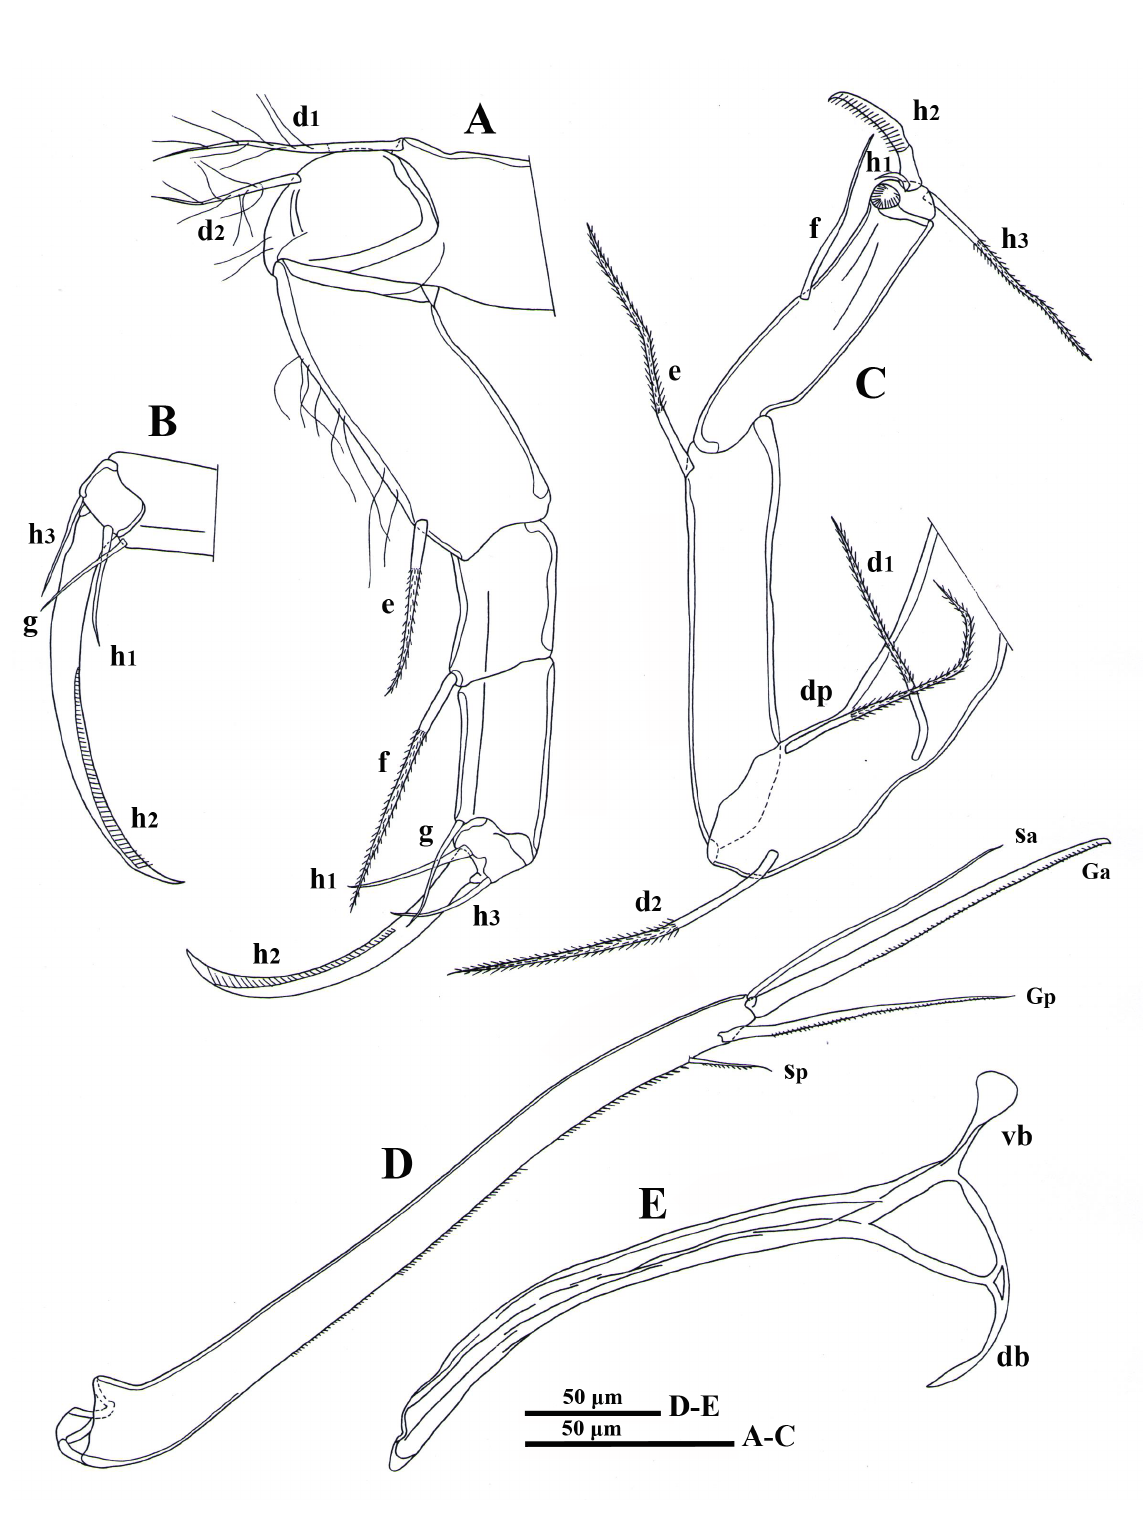
Fig. 5. Pseudostrandesia ratchaburiensis sp. nov. Paratype, ♀ (MSU-ZOC. 292). A . T2. B . Distal part of T2. C . T3. D . CR. E . CR